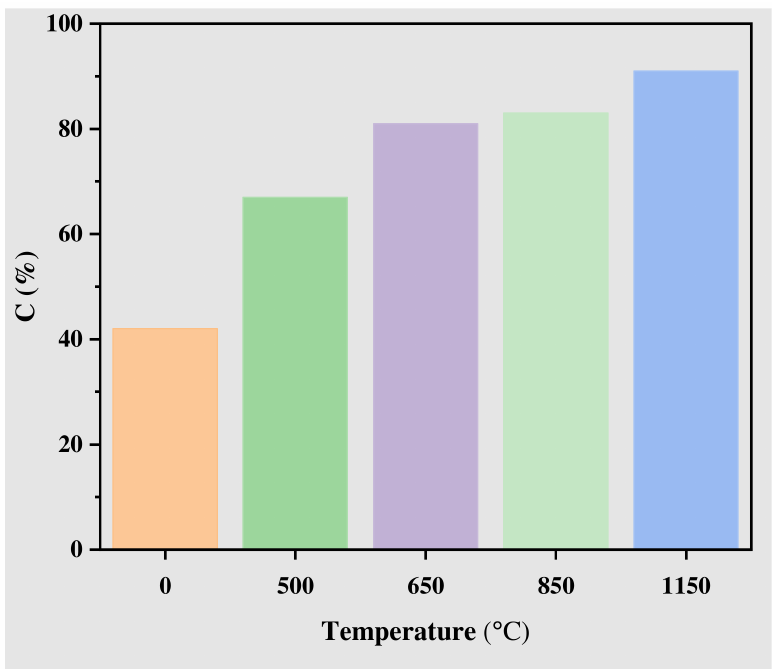
Figure 3. Relationship between temperature and carbon content of activated carbon